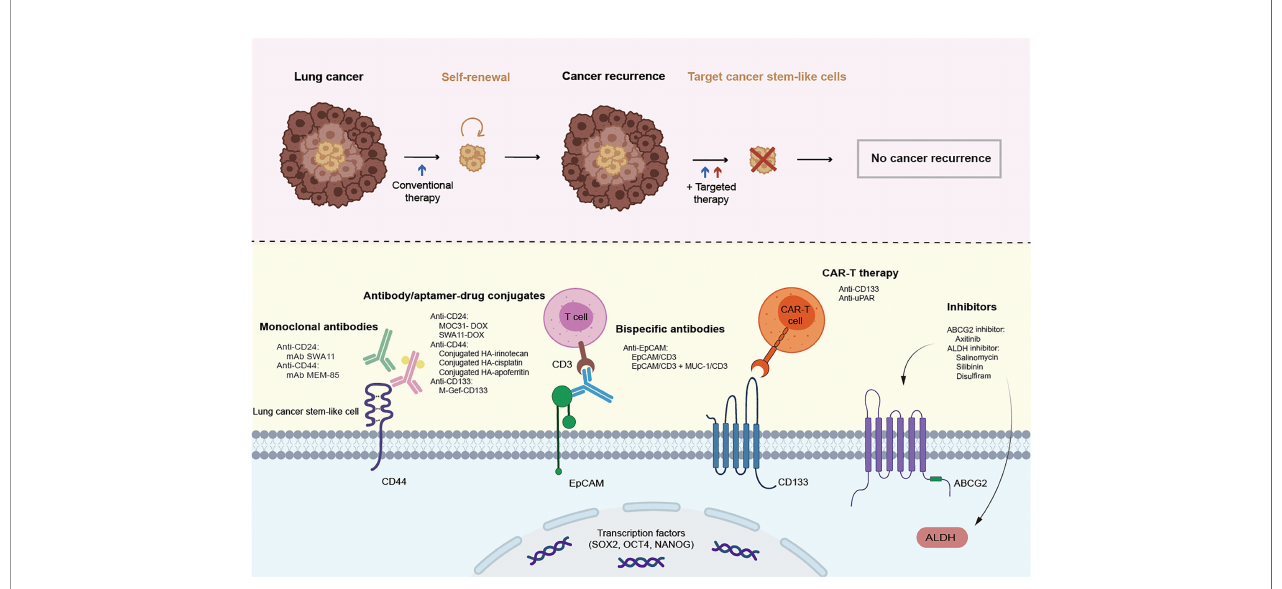
FIGURE 2 | Promising therapies targeting lung cancer stem cell markers. CSCs are resistant to conventional therapy and lead to cancer recurrence, unless being speci fi cally targeted. Therapies targeting lung cancer stem cell markers mainly rely on the speci fi c recognition and binding of antibodies to lung cancer stem cell surface markers, thus leading to a variety of antibody drugs including monoclonal antibody, antibody-drug conjugate, bispeci fi c antibody, and emerging nanoparticle drugs. In addition, novel CAR-T cell immunotherapy as well as inhibitors also play an increasingly important role in the experiments and future clinical